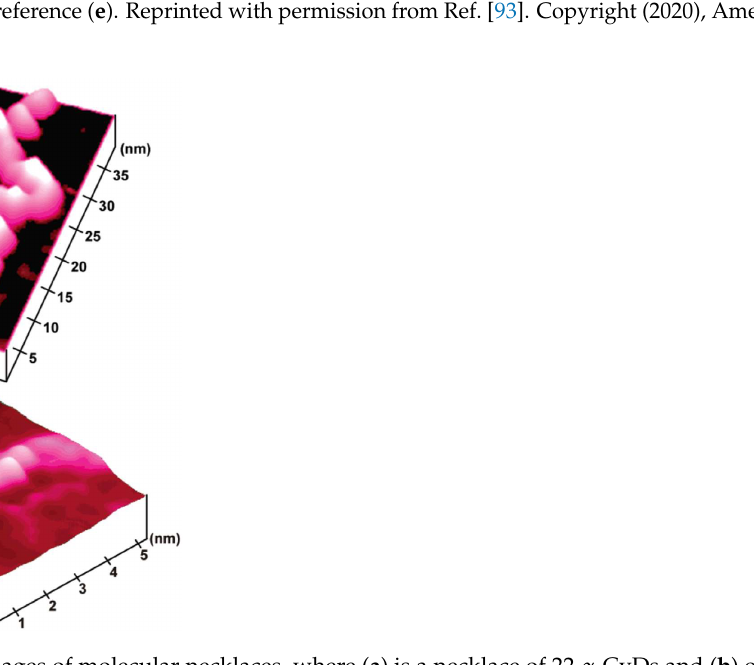
Figure 9. STM image and STM simulation of cellohexaose on Cu(100). The deposition parameters’ control permitted the transition conformers between “extended” and “coiled” forms of cellohex- aose. Reprinted with permission from Ref. [105] . Copyright (2020), American Chemical Society. 4. Relevance of STM Imaging in Biological Applications Imaging single biomolecules have been a long-standing ambition to advance various fields, such as structural biology, biophysics, nanotechnology, and medicine. Exception- ally, direct STM imaging of single biomolecules can be helpful to address medical prob- lems that require structural and dynamic information of biomolecules, mainly those that adopt heterogeneous and non-crystalline structures or for those which crystals cannot be obtained. For example, amyloid fibrils are a central pathological feature of Alzheimer’s disease and other neurodegenerative diseases [107]. The characterization of oligomers preceding the formation of well-defined fibrils and the fibrils themselves are of particular